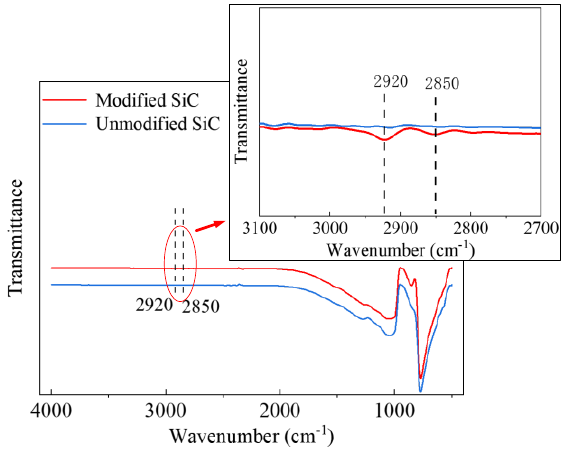
Figure 1. Fourier infrared spectra of unmodified and secondary modified SiC